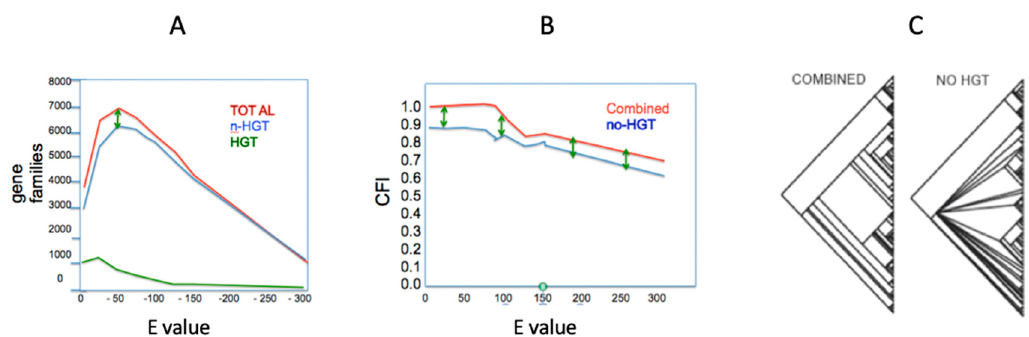
Figure 2. Three results of categorizing gene families as horizontal gene transfer (HGT) or noHGT (see [83] for details). ( A ) The graph represents the plot of E value against number of gene families. Green represents the total number of HGT families, blue represents the total number of noHGT gene families and the red line the total number of gene families at each E value. Most of the impact of HGT occurs at E values less than − 100 and the green arrows indicate the difference in nonHGT and total gene families; ( B ) the graph represents a plot of E value versus the consensus fork index (CFI), a measure of consistency of trees in a dataset. To calculate the CFI, the concatenated tree was used as a standard; ( C ) the impact of removing HGT genes from the dataset on resolution of a phylogenetic tree. When HGT genes are removed from the dataset, basal nodes are deresolved. Reference 84is available from the authors on request.